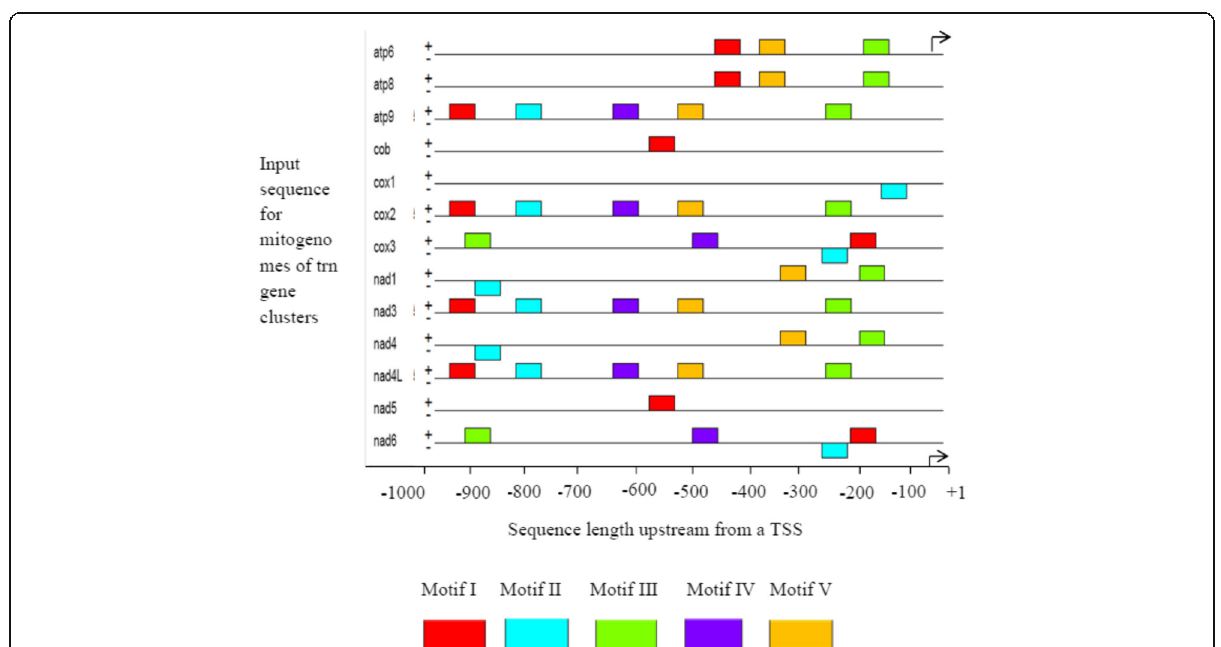
Fig. 1 Block diagrams show distribution and location of input promoter sequence of trn gene candidate motifs